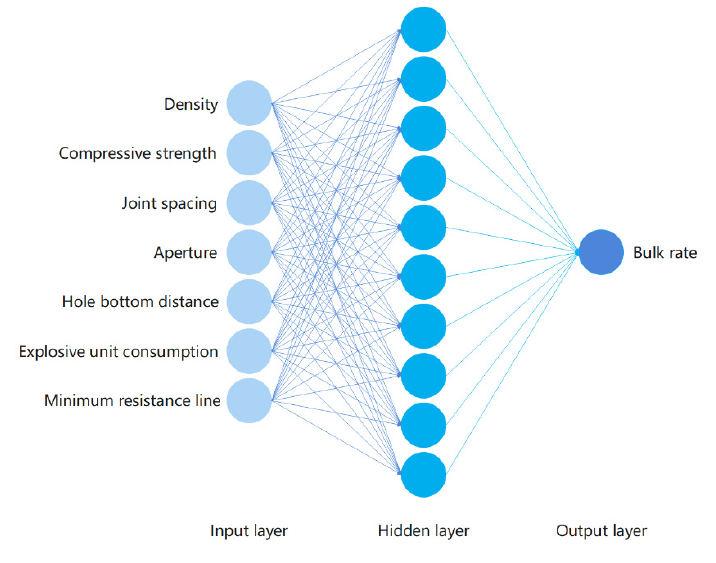
Figure 16. BP neural network model structure.